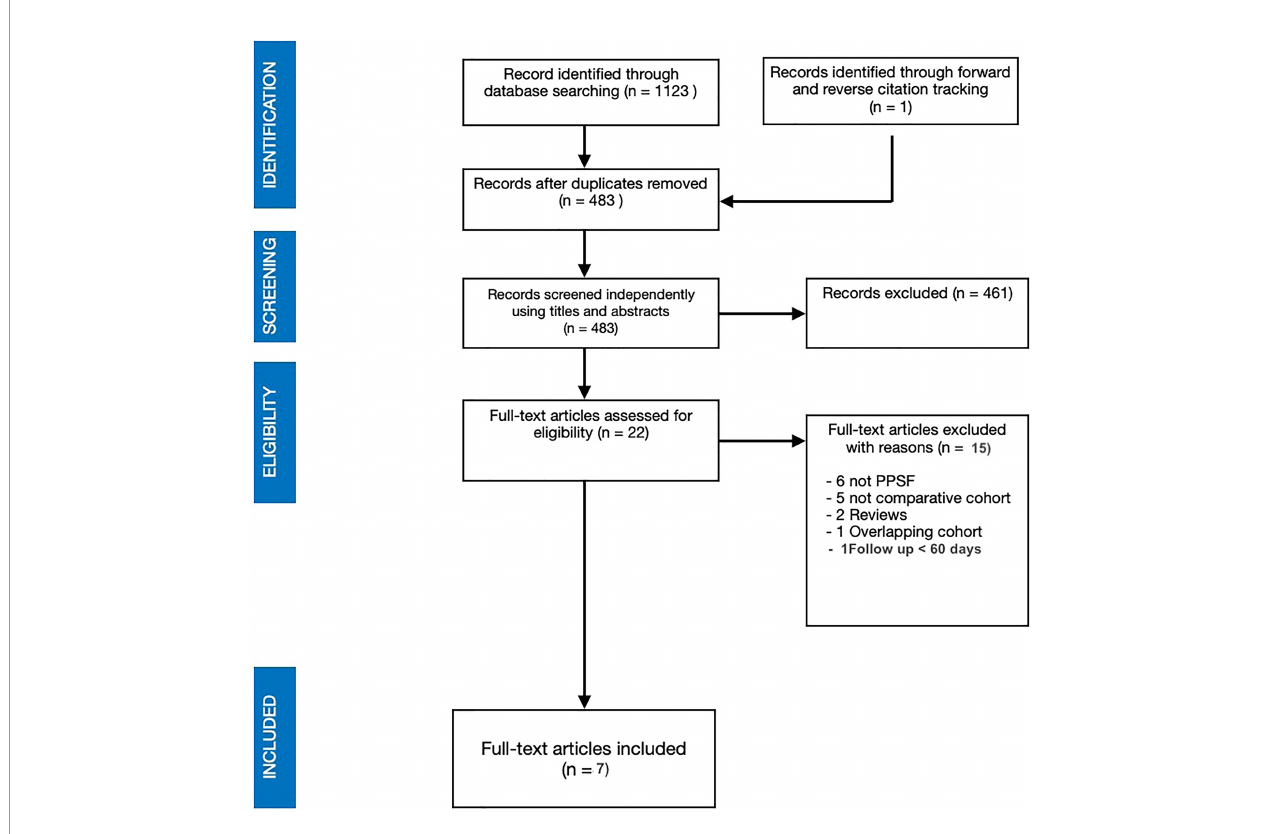
FIGURE 1 | PRISMA search strategy fl ow chart.